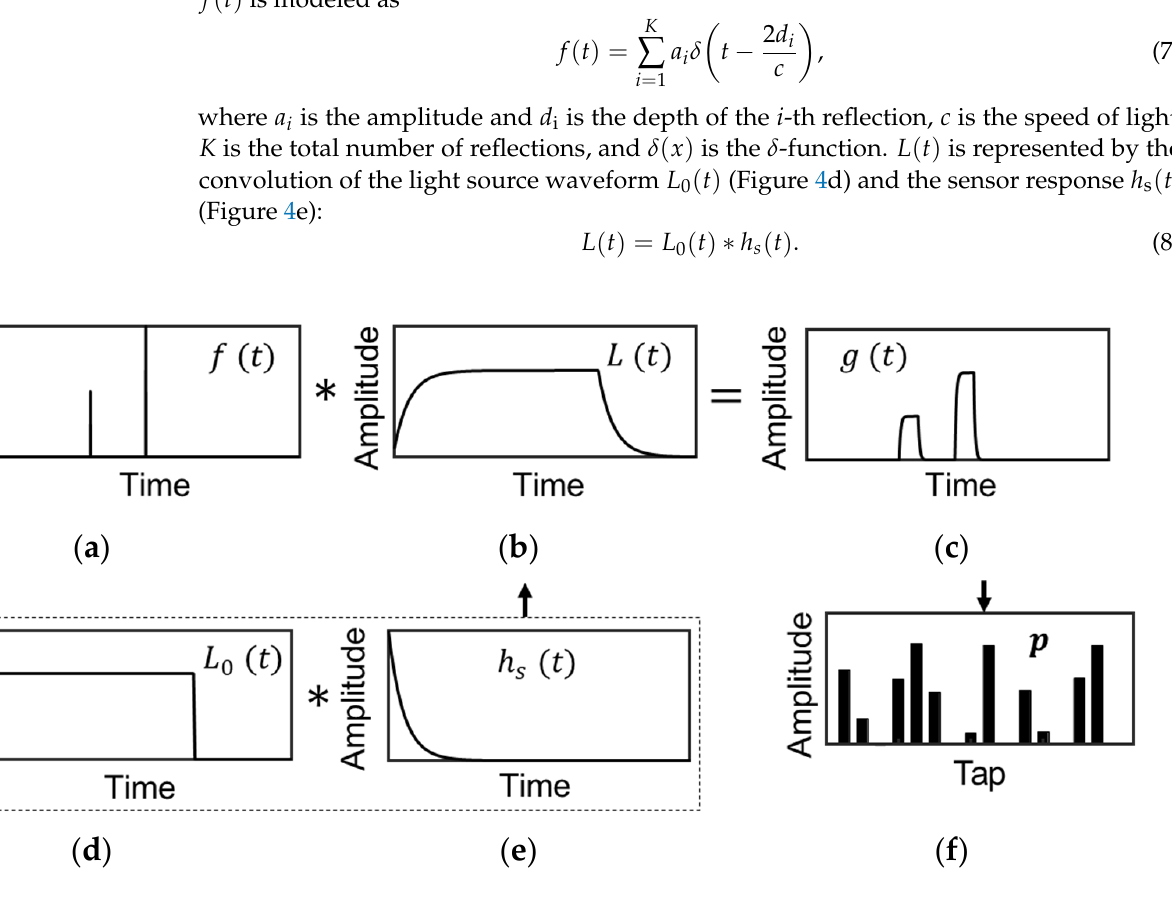
Figure 4. Modeling of multi-path interference in temporally compressive pulse iToF: ( a ) Scene response f ( t ) . ( b ) Total system response L ( t ) . ( c ) Detected light waveform g ( t ) . ( d ) Light source waveform L 0 ( t ) . ( e ) Sensor response h s ( t ) . ( f ) Sensor output p .